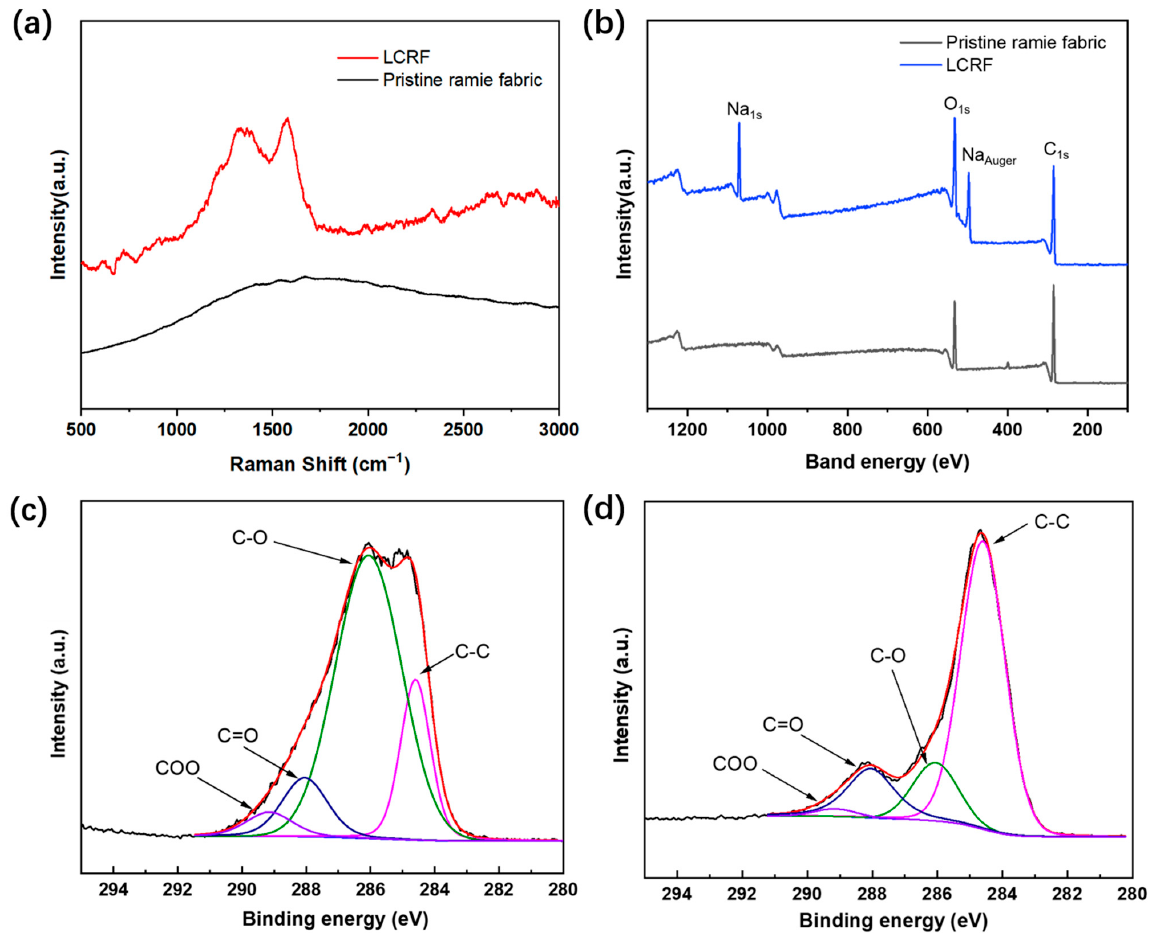
Figure 5. ( a ) Raman spectrum of pristine ramie fabric and LCRF. ( b ) XPS spectra of pristine ramie fabric and LCRF. ( c ) The detailed element information of the C 1s XPS spectra for pristine ramie fabric. ( d ) The detailed element information of the C 1s XPS spectra for LCRF.